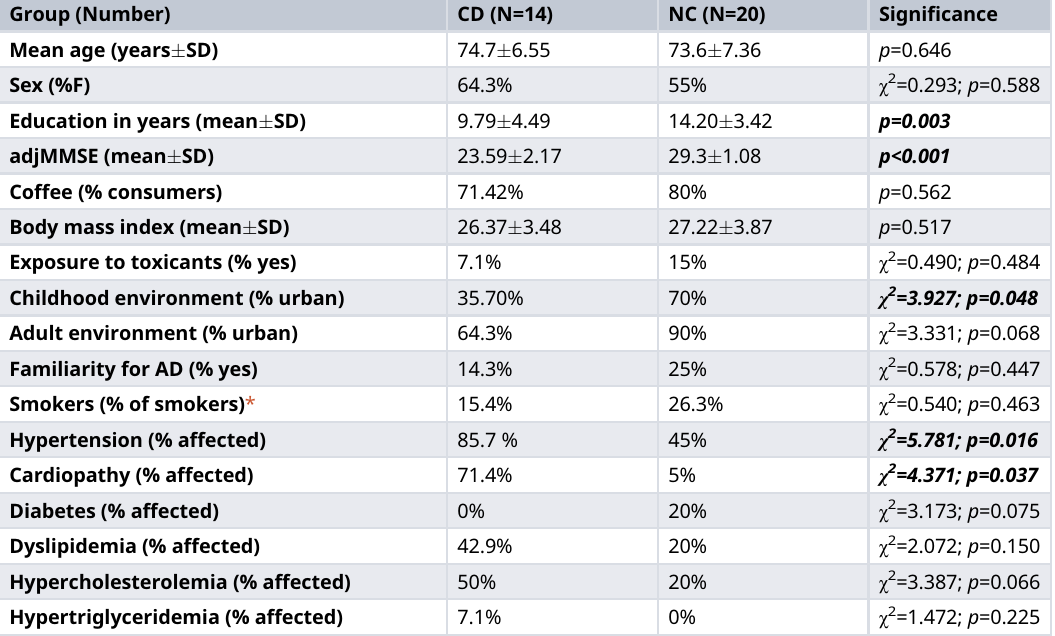
Table1.Demographicandclinicalcharacteristicsoftheindividualsincludedinthestudy. Differencesbetween CD and NC individuals were evaluated using the t-test for continuous and the χ 2 test for categorical